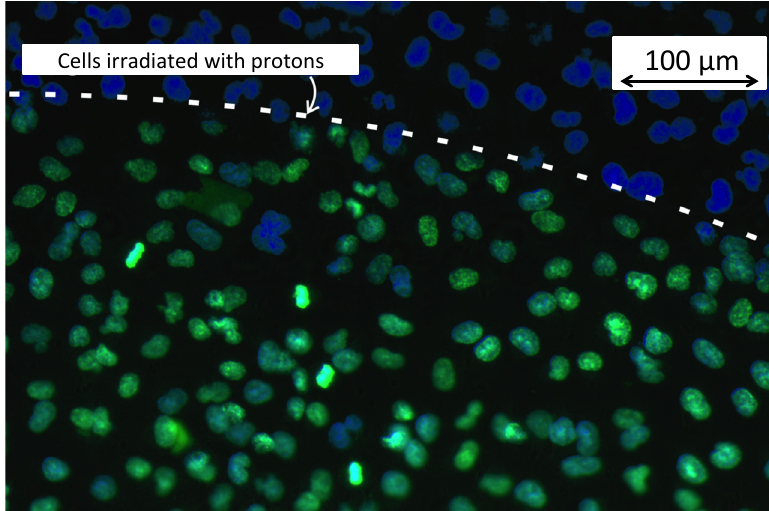
Figure 19. DNA double-strand breaks [98] induced by the irradiation of laser-accelerated protons with 20 Gy, indicated with the green signals.